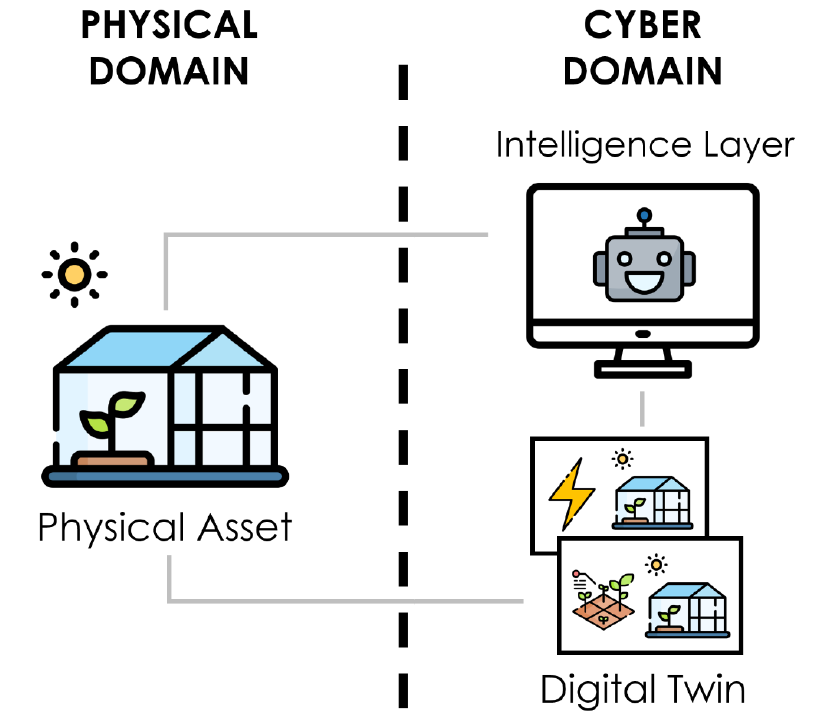
Figure 1. Actors involved in a DT architecture. The representation has been adopted from